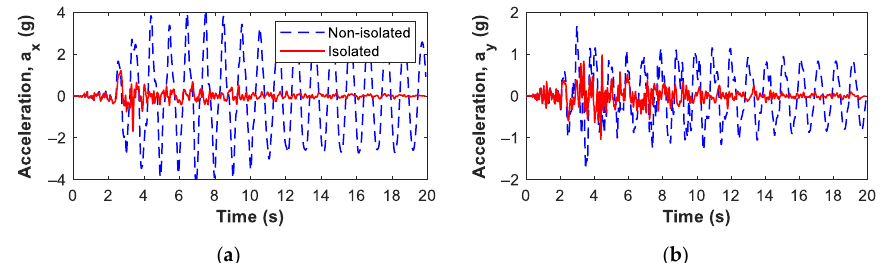
Table 2. Peak seismic response of the building.